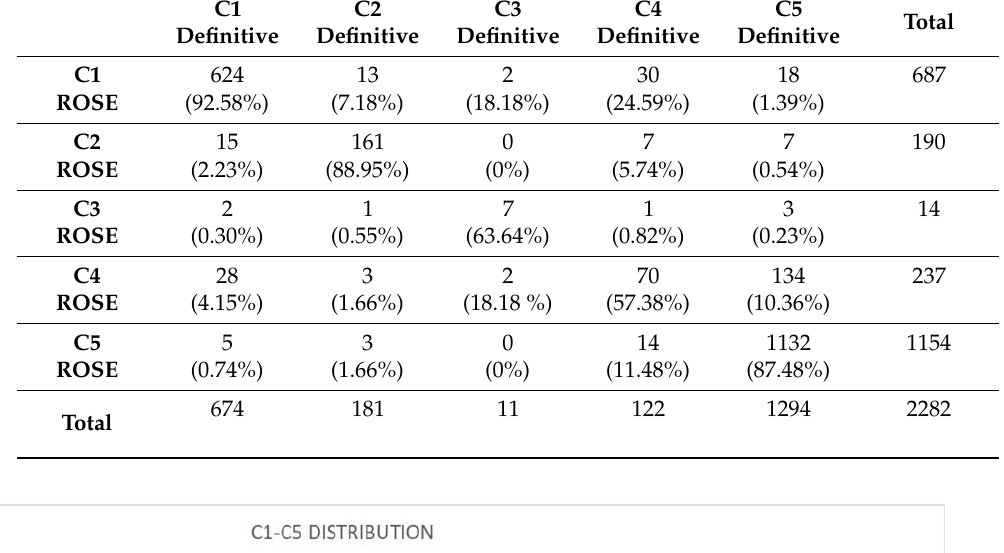
Table 3. C1–C5 classification distribution during ROSE and in definitive diagnoses (percentage refers to the incidence of ROSE categories (rows) out of the total number of each single category defined by final cytological diagnosis (columns)).